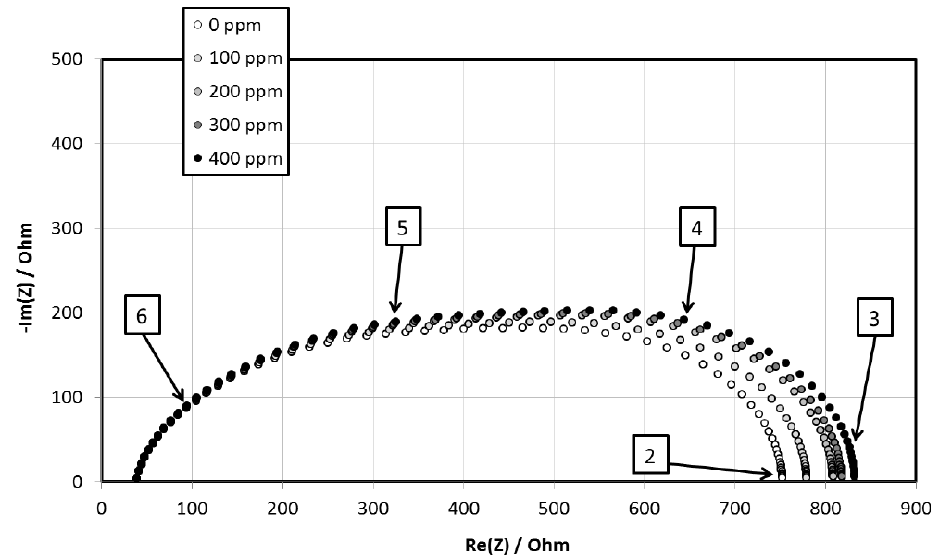
Figure 7. Impedance spectra evolution of 5% BA sample at 200 °C for various nitrogen oxide partial pressures.